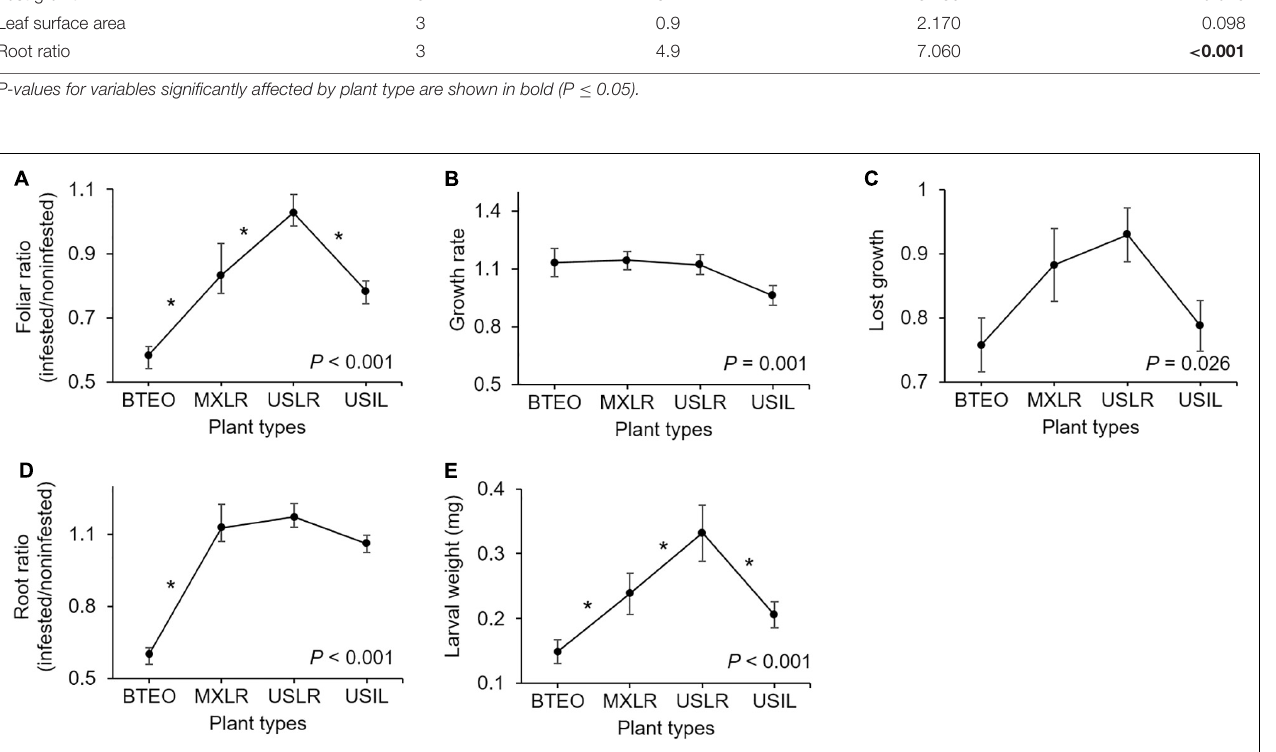
( G = 17.82, 2 d.f., P < 0.001), US landraces and US